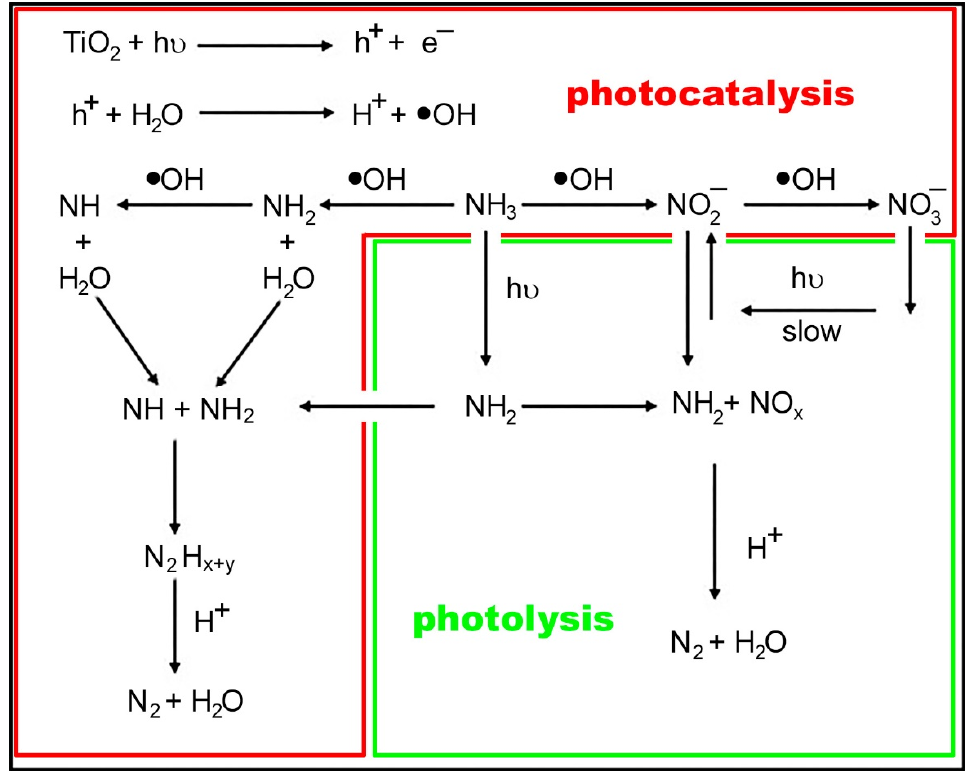
Figure 13. The proposed two parallel reaction mechanism for NH 4+ /NH 3 degradation by photolysis and photocatalysis. and